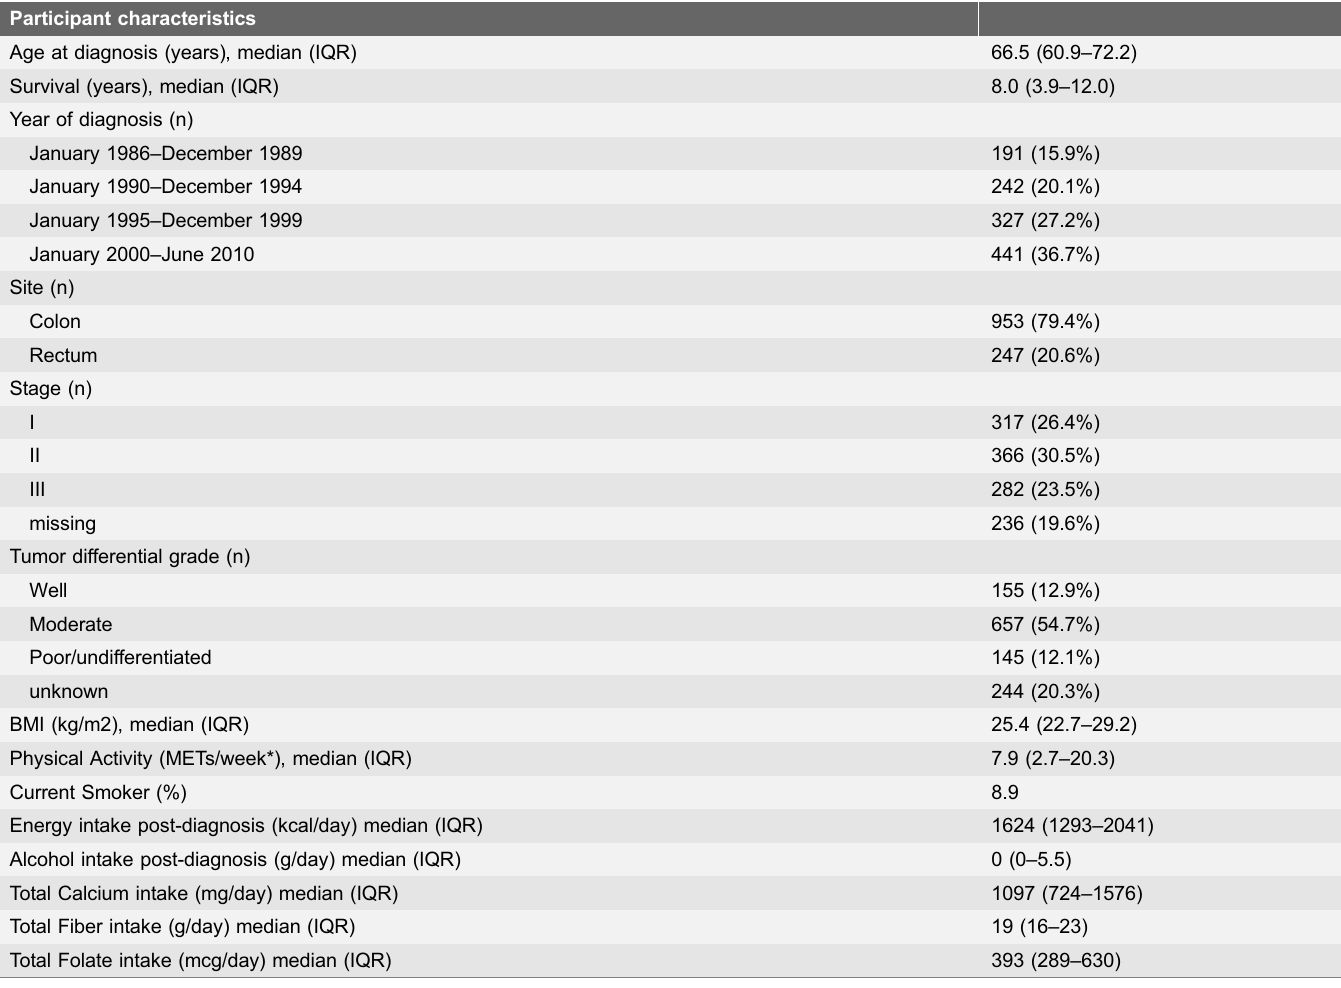
Table 1. Health and lifestyle characteristics at entry to analysis (n 5